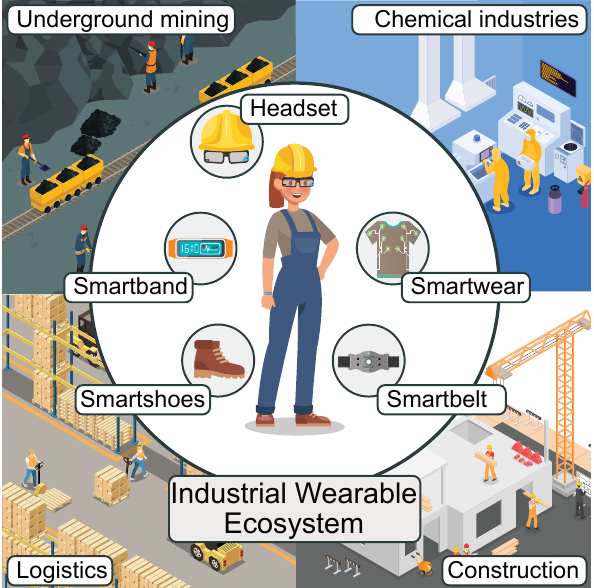
Figure 1. The concept of using wearable devices in industries to maintain work